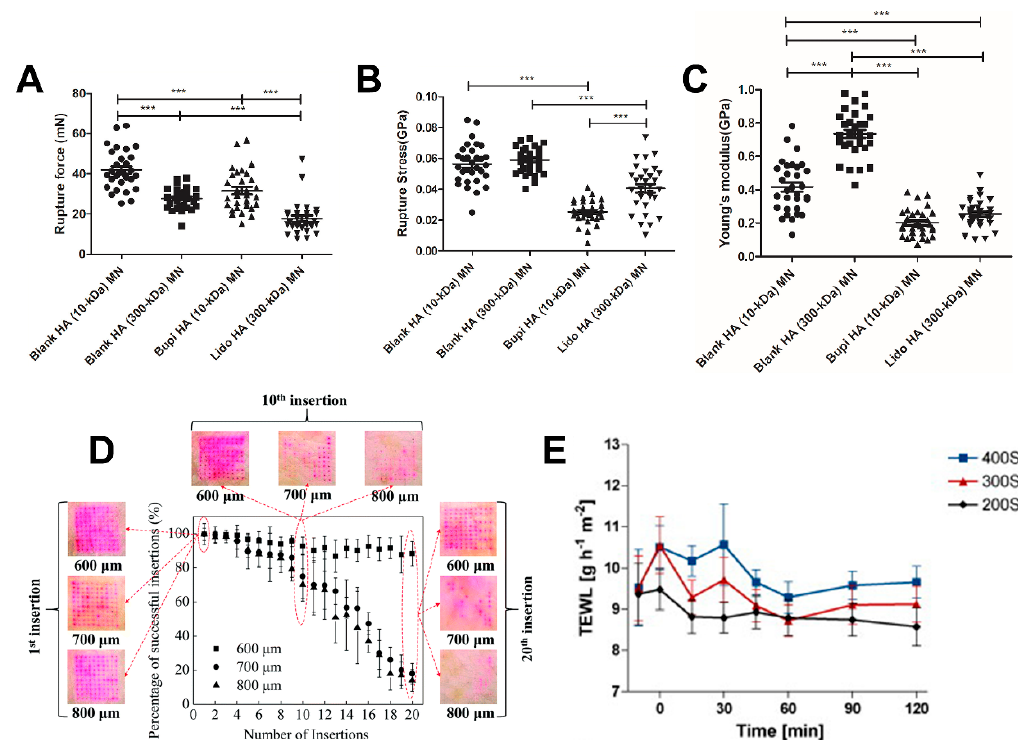
Figure 13. ( A ) Rupture forces of four types of MNs. ( B ) Rupture stress of four types of MNs. ( C ) Young’s modulus of four types of MNs. ( D ) The relationship between PLA MN insertion success rate and insertion times with different heights (600, 700 and 800 µ m). ( E ) Skin irritation and barrier disruption were assessed by TEWL (200S as 200 µ m, 300S as 300 µ m, 400S as 400 µ m). In ( A – C ), one-way ANOVA analysis is applied, and the significant difference is indicated by * p < 0.05, ** p < 0.01, *** p < 0.001. (Image was reproduced with permission from [111–113]).